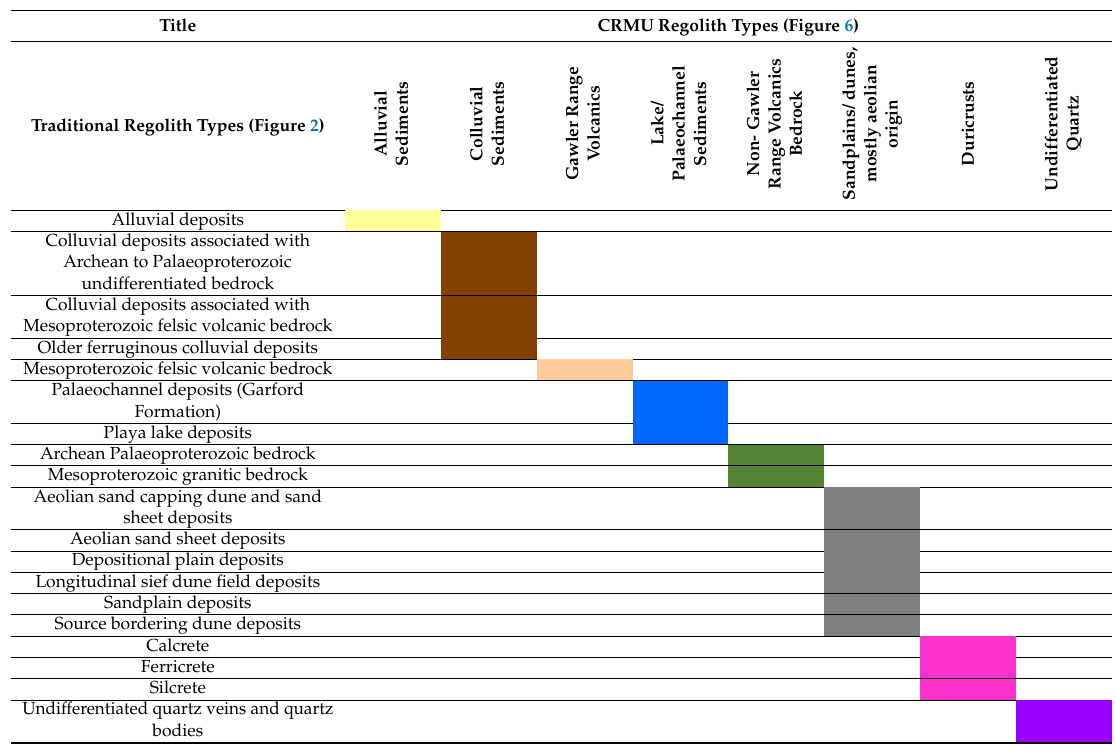
Table 1. Matrix showing aggregation of 19 regolith types from Figure 3 into 8 Clustered Regolith Mapping Units (CRMU) in Figure 4. Each color represents the color of the aggregated class displayed in Figure